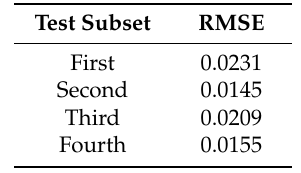
Table 4. The RMSE values of the four test subsets.